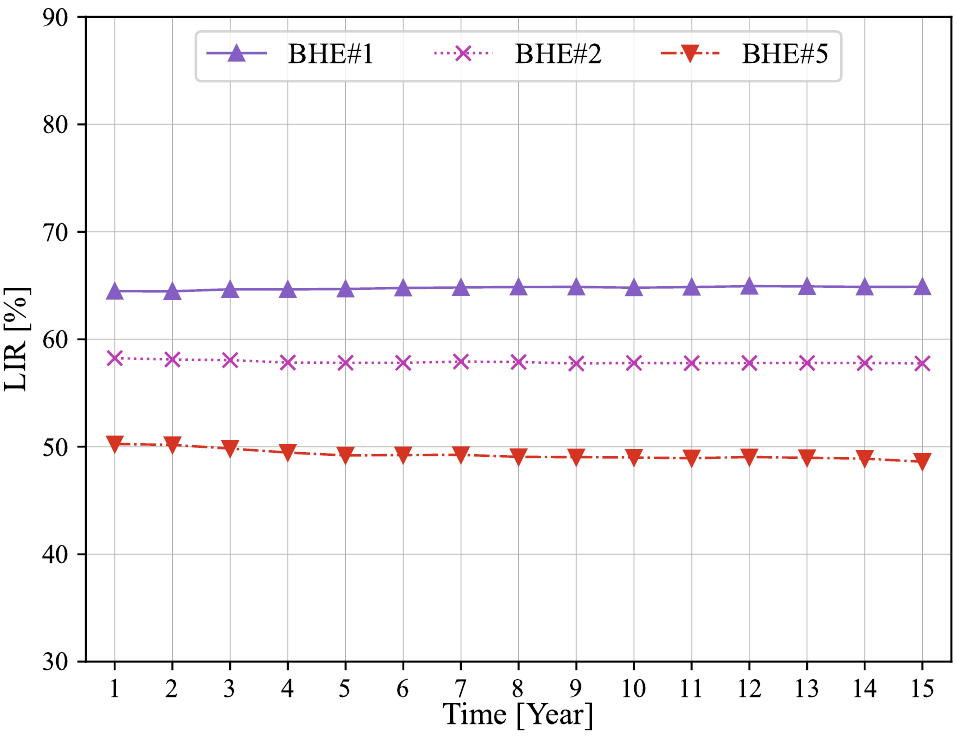
Figure 13. Evolution of the load imbalance ratio of the selected MSBHE under scenario #7 over 15